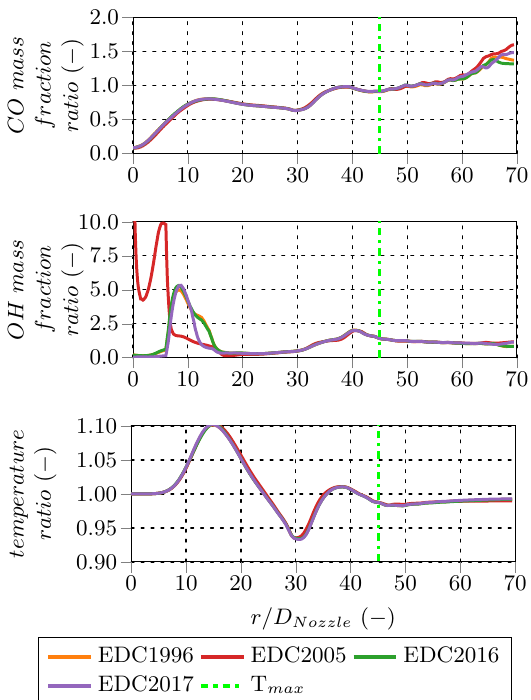
Figure 11. Ratios of PFR versus PSR centerline profiles of intermediate species (CO, H 2 , and OH) mass fractions and temperatures (T) of flame D for all EDC model variations. Not all EDC versions are visible due to overlapping